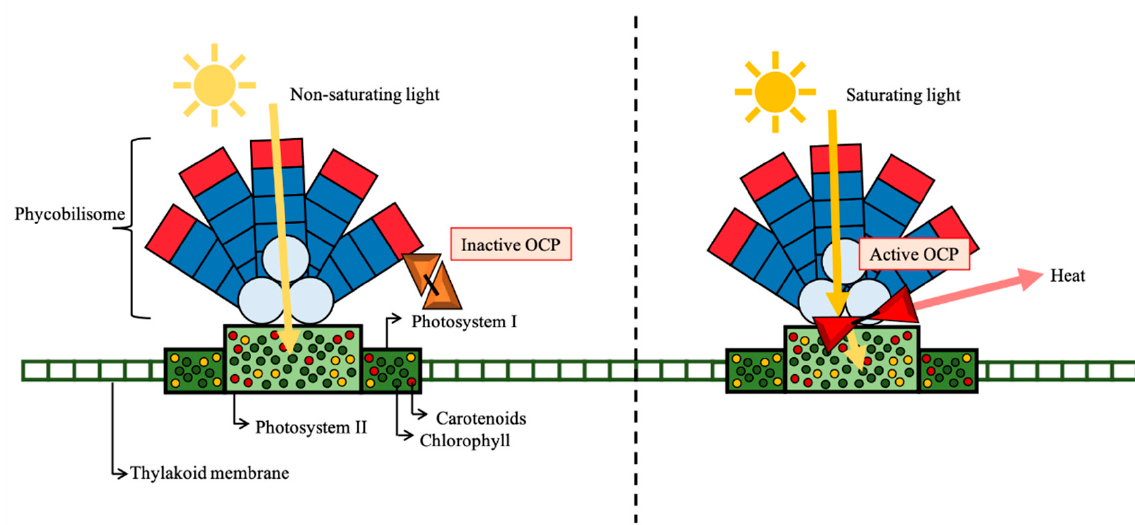
Figure 2. Orange carotenoid protein (OCP) energy dissipation under saturation light.